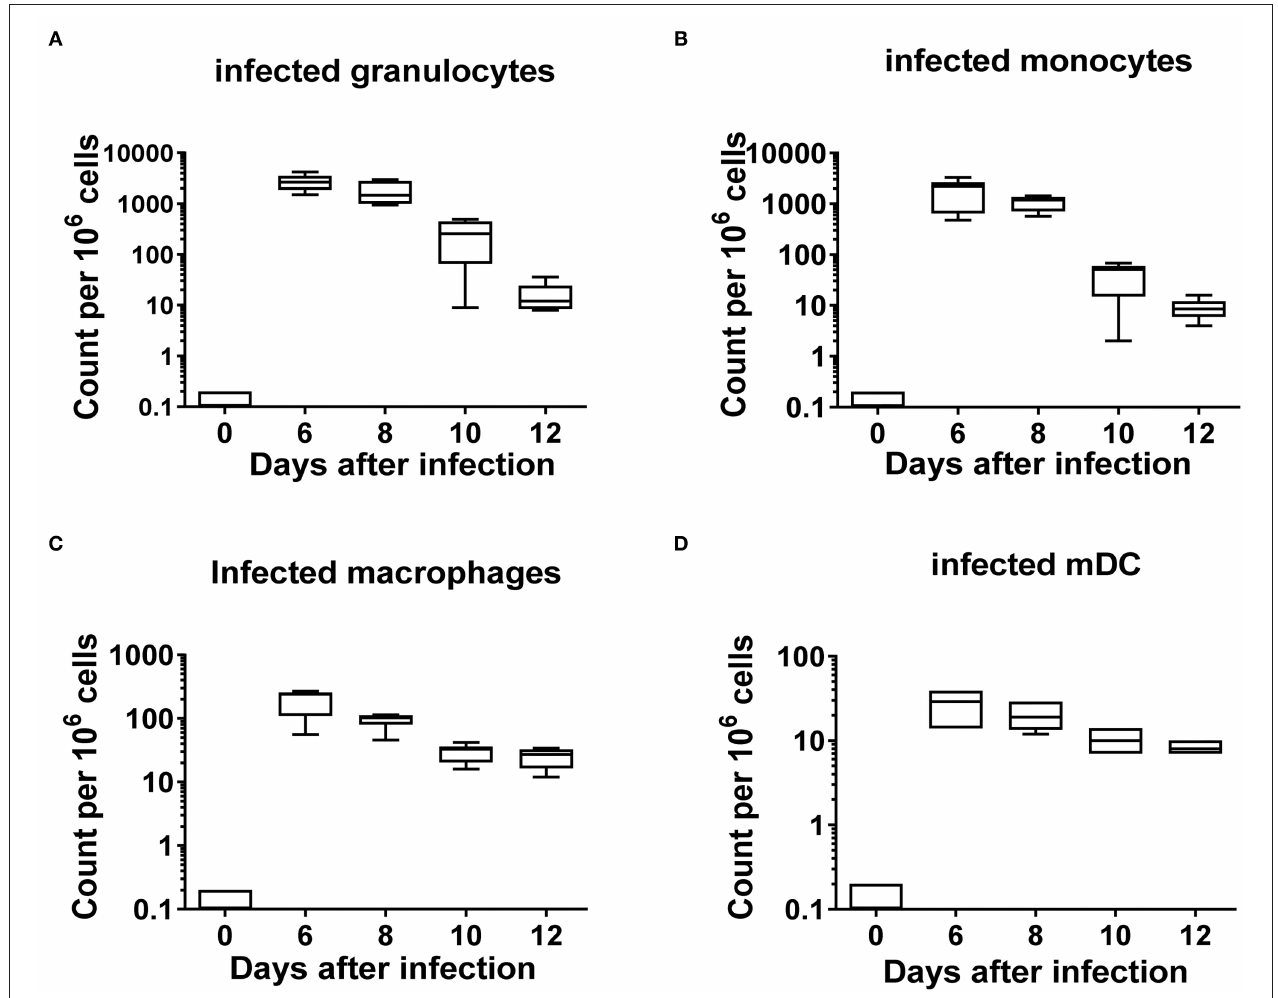
FIGURE 2 | Frequencies of FV infected subpopulations of myeloid cells. C57BL/6 mice were infected with FV encoding m-Wasabi and splenocytes were isolated at different time points after infection. Multi-parameter flow cytometry analysis was used to analyze the kinetics of different infected (mWasabi + ) myeloid subpopulations. A box plot showing the frequencies per one million cells of infected granulocytes (CD11b + Ly6C low Ly6G high mWasabi + ) (A) , monocytes (CD11b + Ly6C high Ly6G low m-Wasabi + ) (B) , macrophages (CD11b + Ly6G − Ly6C − F4/80 + CD11c low mWasabi + ) (C) , and mDC (CD11b + Ly6C − Ly6G − CD11c + mWasabi + ) (D) . Each bar represents the mean number plus SEM per one million nucleated cells for a group of 5–9 mice. Data were pooled from three independent experiments with similar results.